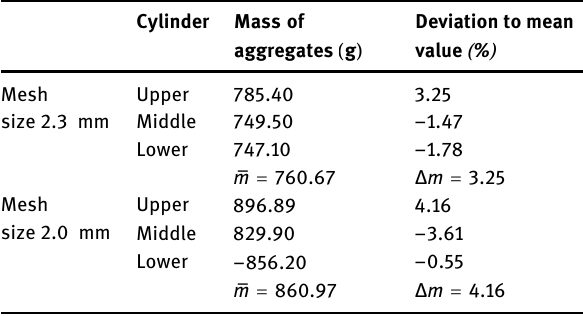
Table 4: Results of the cylinder sedimentation test